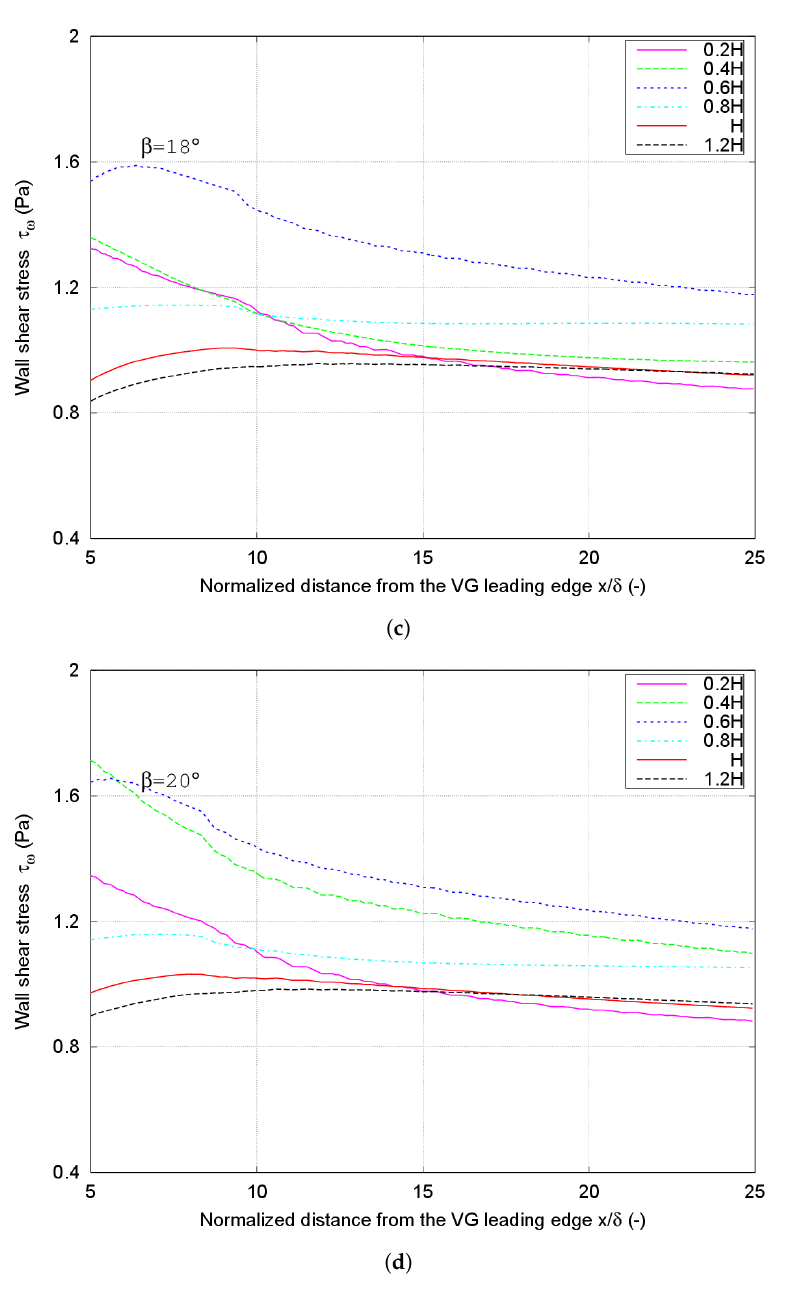
Figure 8. Wall shear stress at different planes normal to the streamwise direction and located at distances proportional to the local boundary layer thickness δ from the trailing edge is shown for six vortex generator heights (0.2H, 0.4H, 0.6H, 0.8H, H, and 1.2H). Four different incident angles are represented, ( a ) corresponds to β = 10 ◦ , ( b ) 15 ◦ , ( c ) 18 ◦ , and ( d ) 20 ◦ . The wall shear stress shows the highest value for the 0.6H VG height case for all the incident angles. For the incident angle β = 10 ◦ , the 0.4H VG height case starts with a big value and decreases as the cutting planes are farther from the VG trailing edge. The wall shear stress varies with the vane